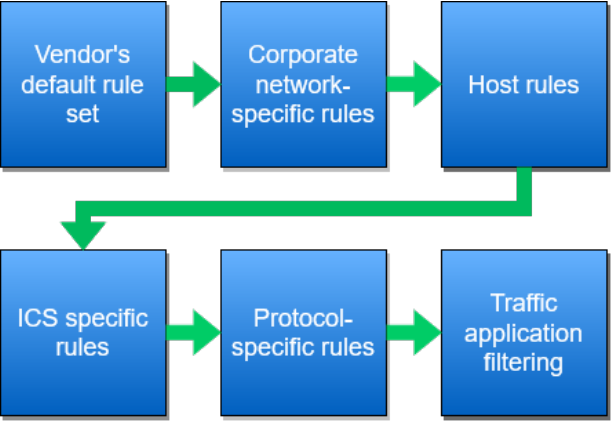
Figure 2. CISA Recommended Firewall Rule Set